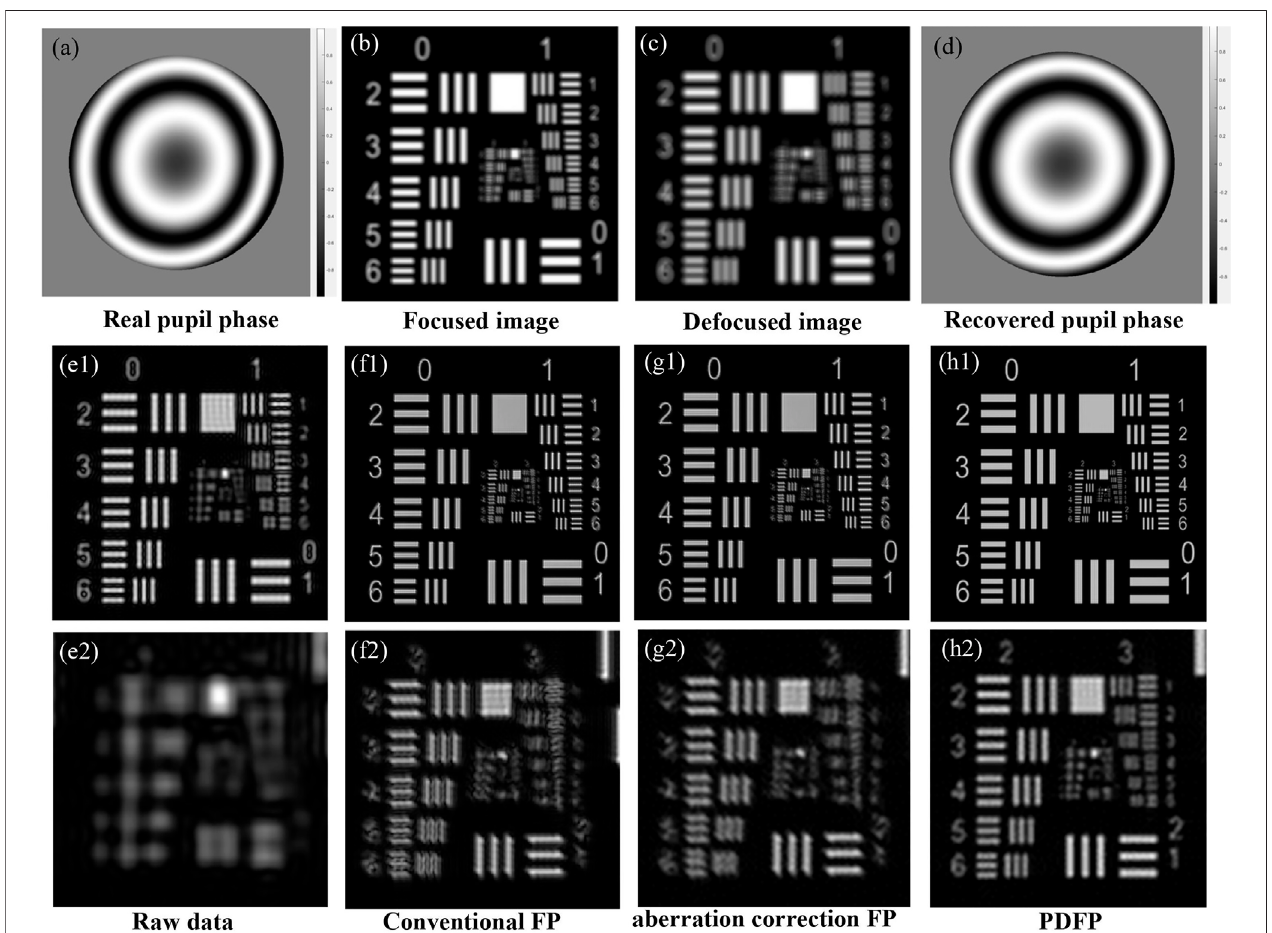
FIGURE 3 | The comparison of simulation experimental results by the conventional Fourier ptychography (FP), aberration correction FP, and the proposed phase diversity-based FP (PDFP) method. (A) The real pupil phase. (B) The focused image. (C) The defocused image. (D) The recovered pupil phase by the phase diversity algorithm. (E1) Thelow-resolutionrawdata. (F1) TherecoveredresultswithconventionalFP. (G1) ThecorrectionresultsbyaberrationcorrectionFP. (H1) Thecorrection results of our PDFP method. (E2 – H2) Close-ups of panels (E1 – H1) .